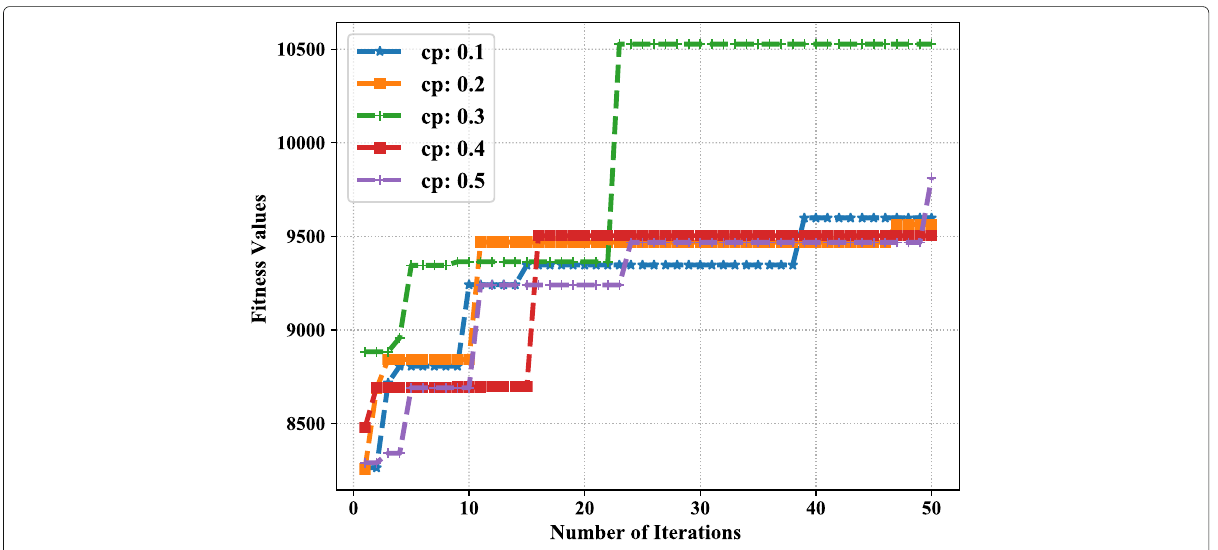
Fig. 4 Fitness values with different values of crossover probability